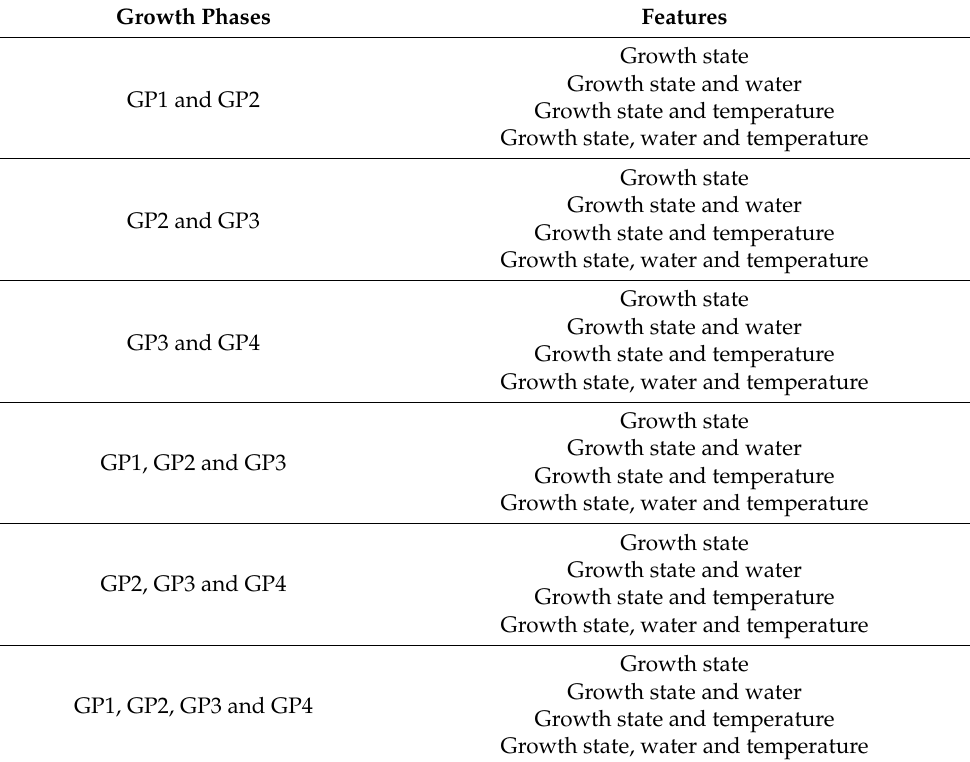
Table 3. The different combinations of growth phases and